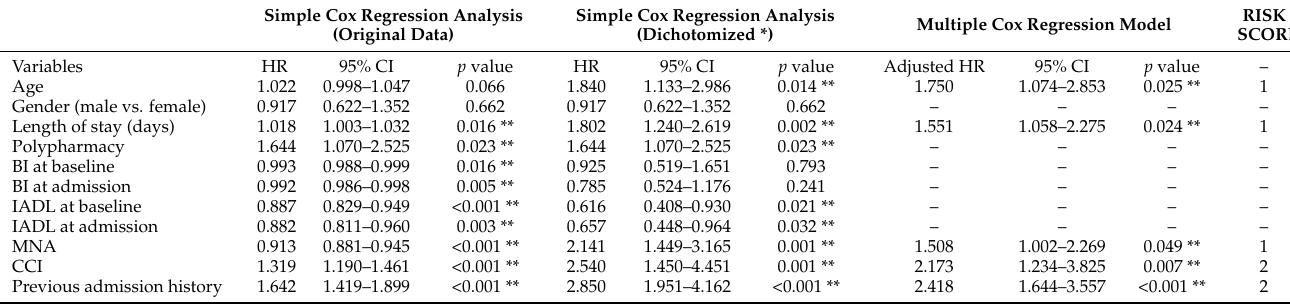
Table 2. Risk factors and Cox regression analysis (one year mortality).